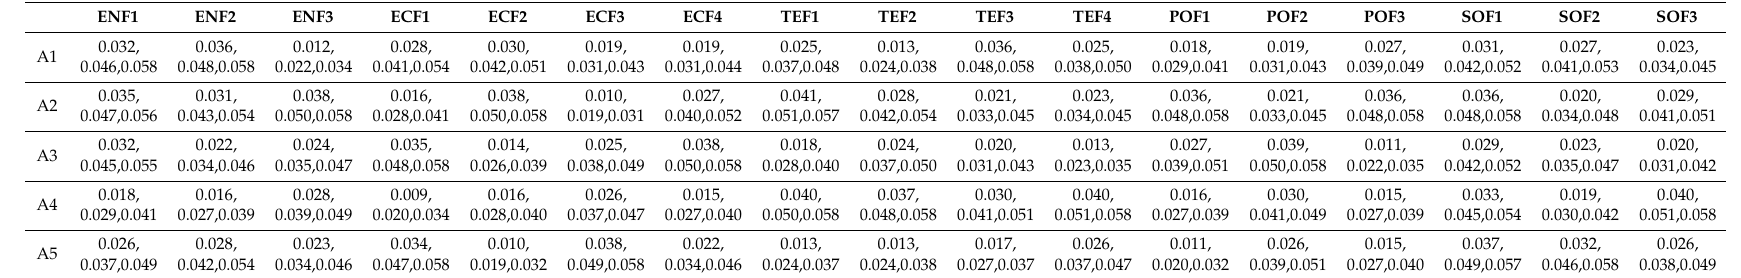
Table A11. Fuzzy weighted normalized matrix for WSM.